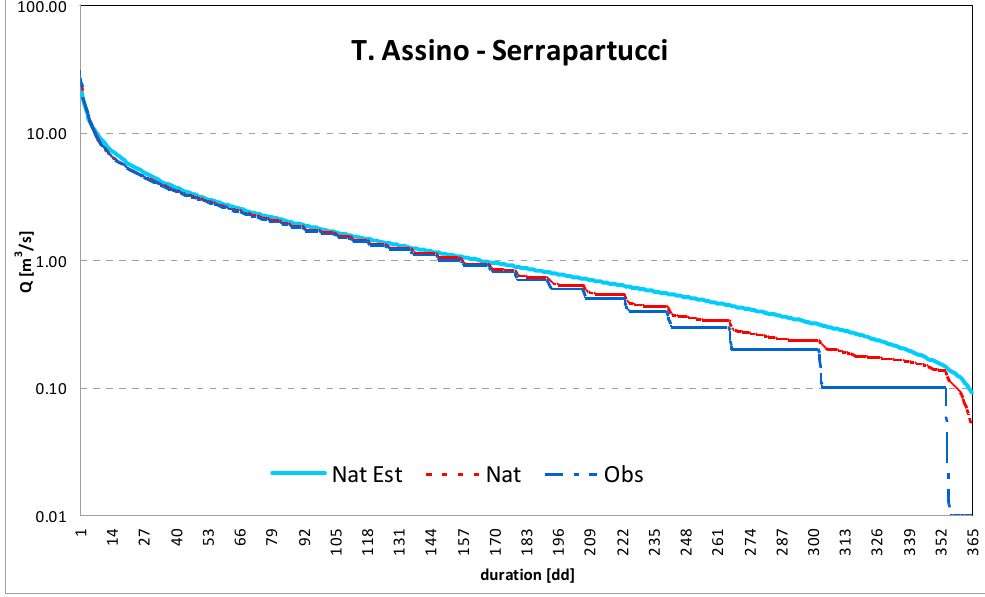
Figure 5. Average FDCs in the Serrapartucci basin. Estimated natural FDC (Nat Est), natural FDC (Nat), and observed FDC (Obs).